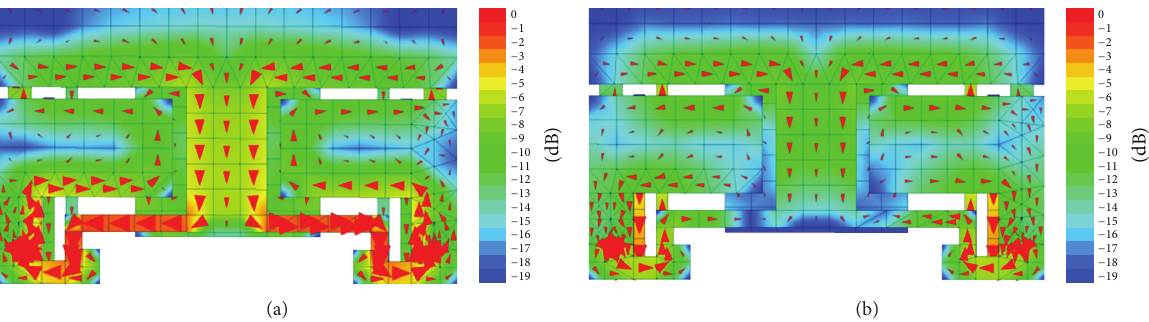
Figure 4: (a) Surface current distribution at 780 MHz of the back side of the antenna. (b) Surface current distribution at 2.350 GHz of the back side of the antenna.